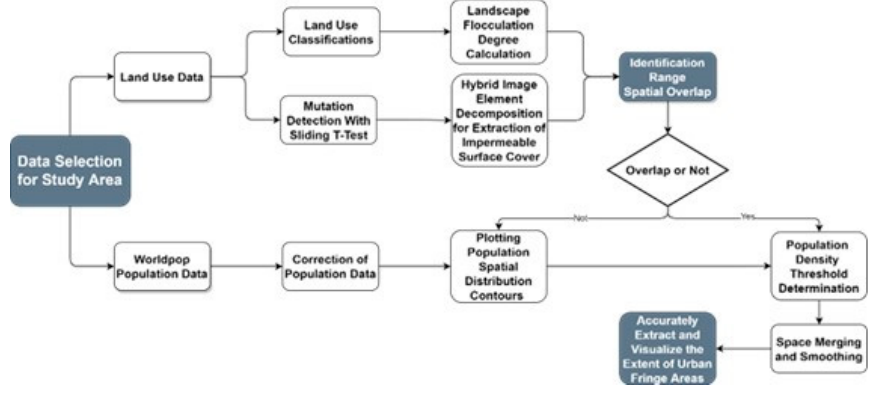
Figure 2. Workflow